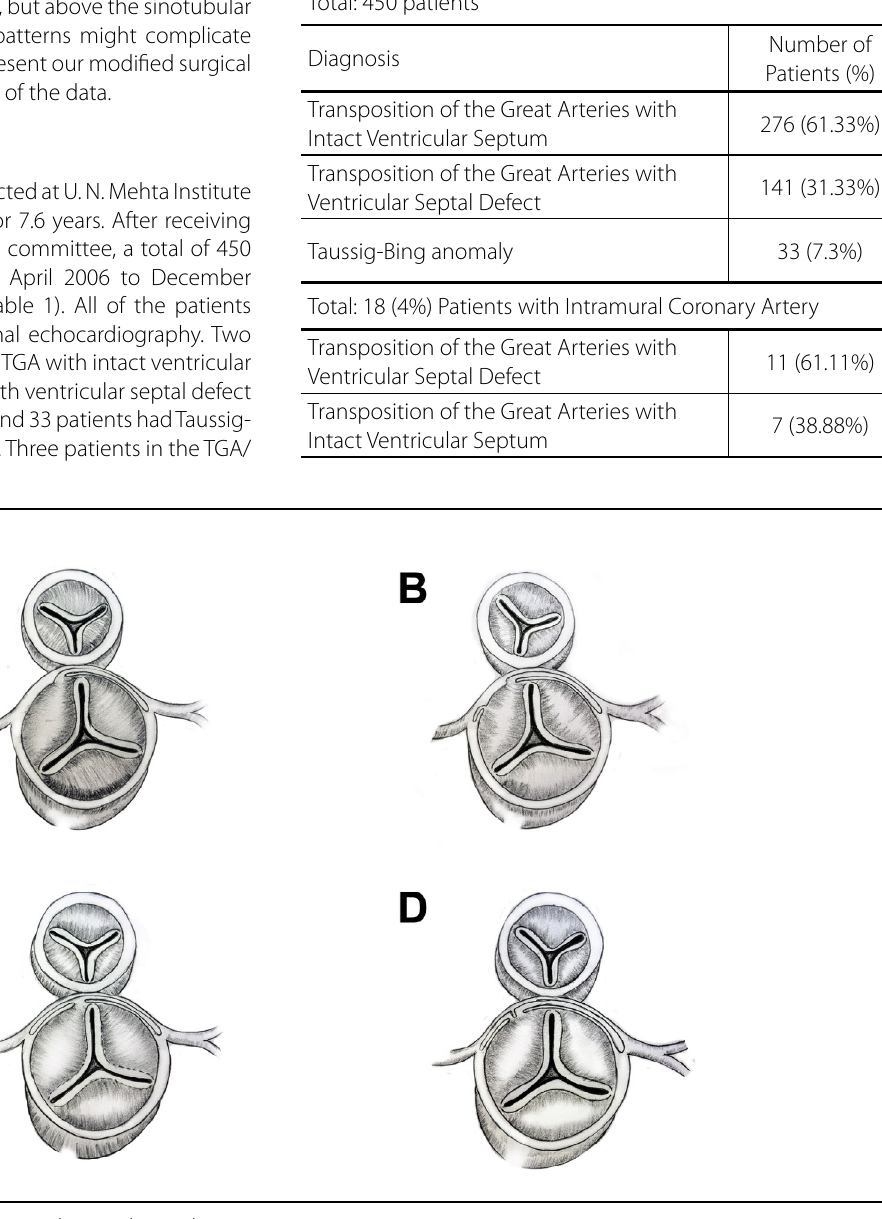
Fig. 1 - Intramural coronary artery pattern observed in eighteen patients. A- Intramural left coronary artery with normal origin of right coronary artery (9 patients). B- Intramural left and right coronary artery with separate openings (1 patient). C- Intramural left and right coronary arteries with single ostia (7 patients). D- Intramural left and right coronary artery with kissing ostial openings (1